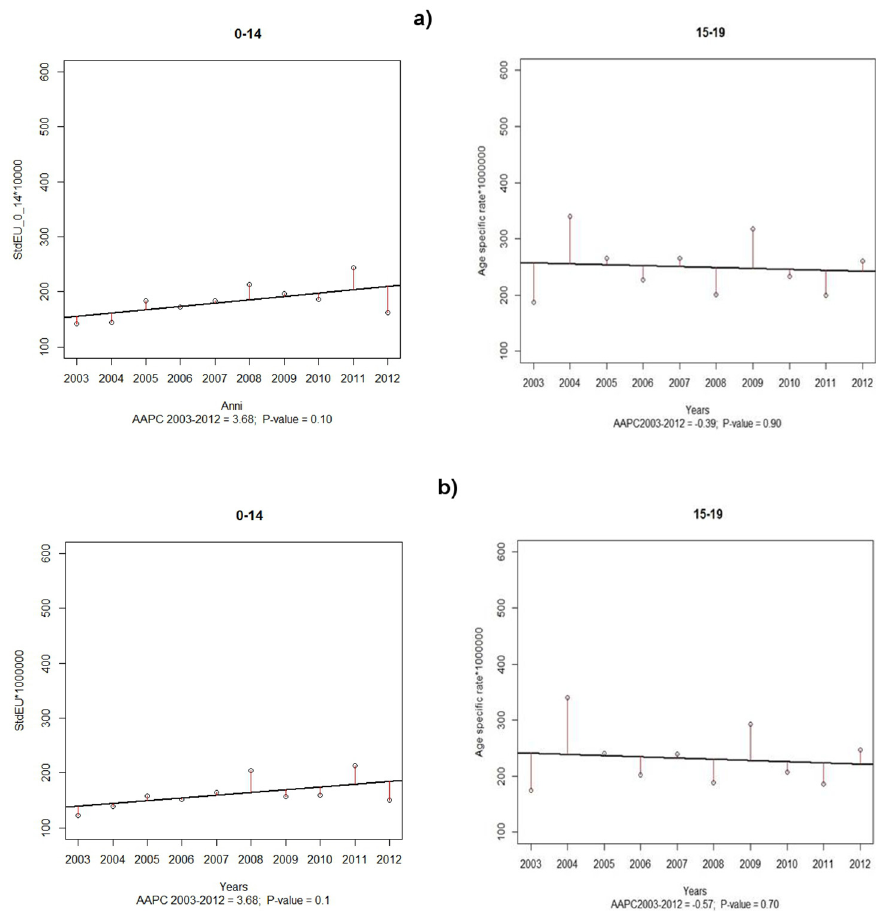
Figure 2. Average Annual Percentage Changes for ( a ) “all tumours” (males and females together) and ( b ) “malignant tumours”, by age-groups. Palermo Province, 2003–2012. Figure 2 legend. AAPC: Annual Average Percentage Change.